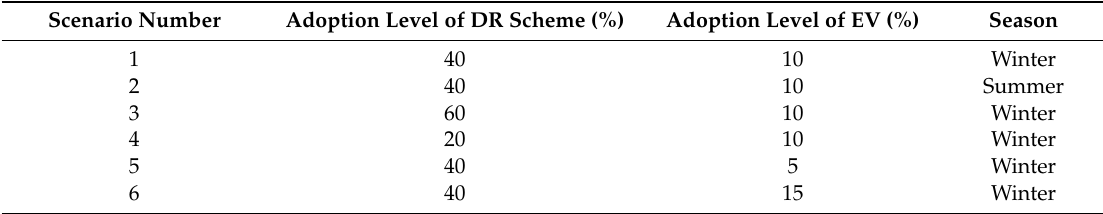
Table 3. Description of the adoption levels of DR technologies and EV ownership within each scenario. Scenario Number Adoption Level of DR Scheme (%) Adoption Level of EV